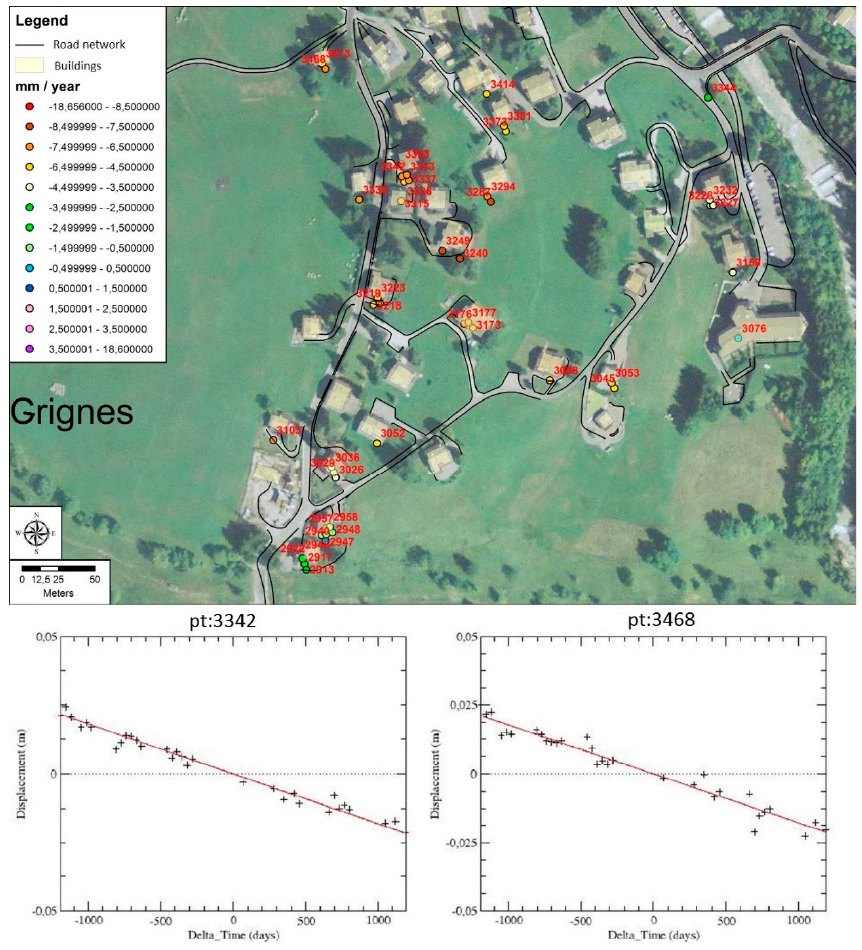
Figure 8. Displacements for the village of Grignes. The red line that interpolates data for the PS allows estimation of the mean velocity along the line of sight of the radar.